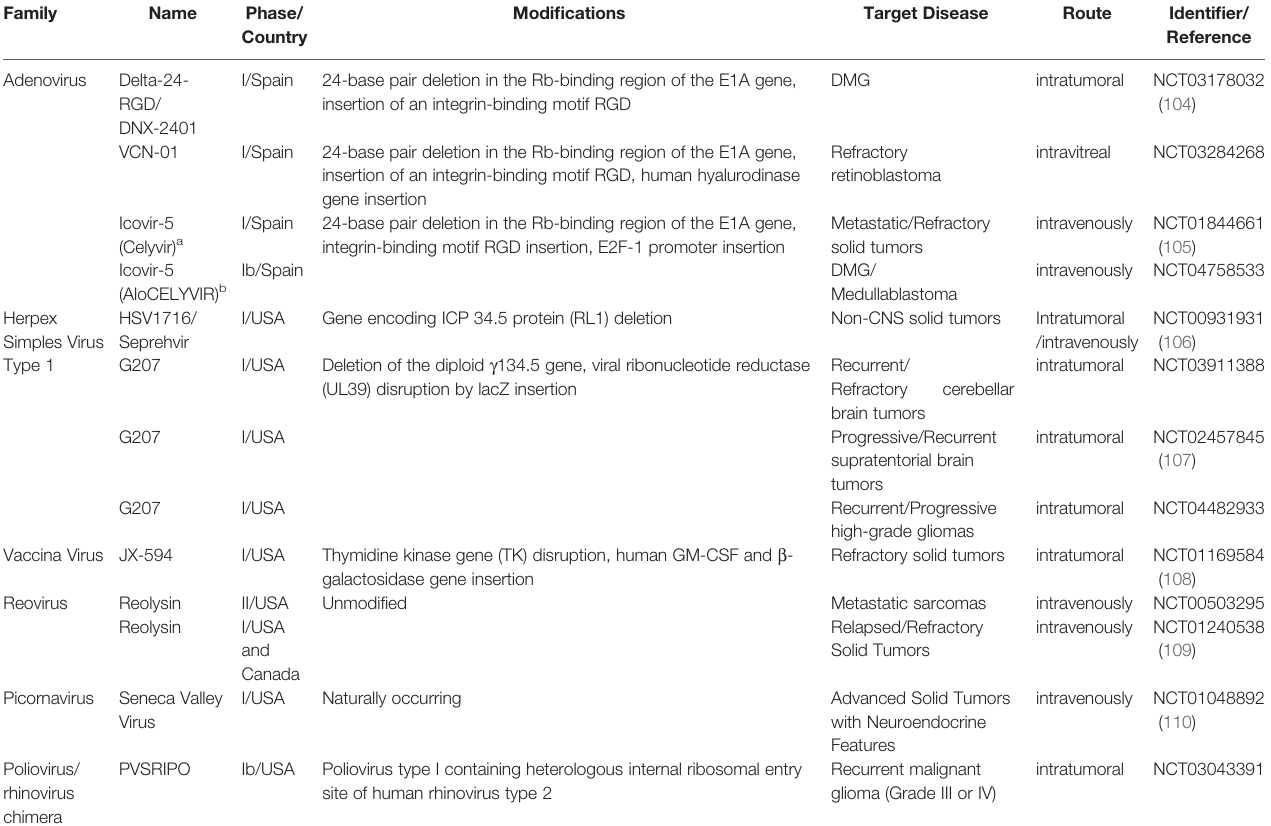
TABLE 1 | Clinical trials, completed or active, using oncolytic viruses as treatment in pediatric solid tumors.